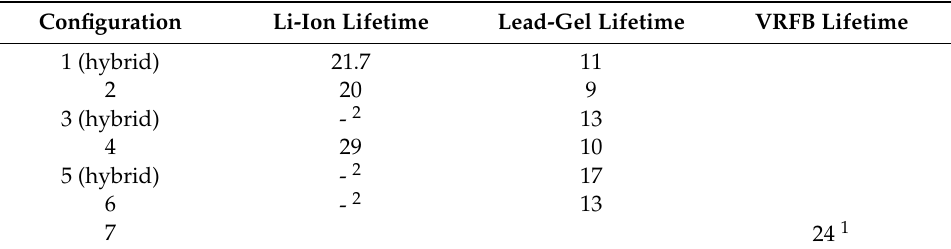
Table 6. Expected battery lifetime— L Kit load profile.